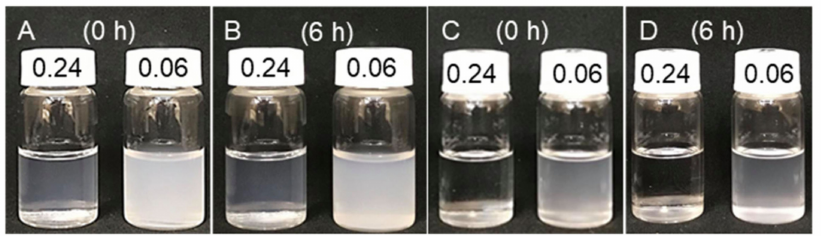
Figure 10. Photographs of dispersion of MgGa(CO 3 )-x_F in water ( A , B ) and MgGa(DS)-x_F in hexanol ( C , D ) before and after the storage for 6